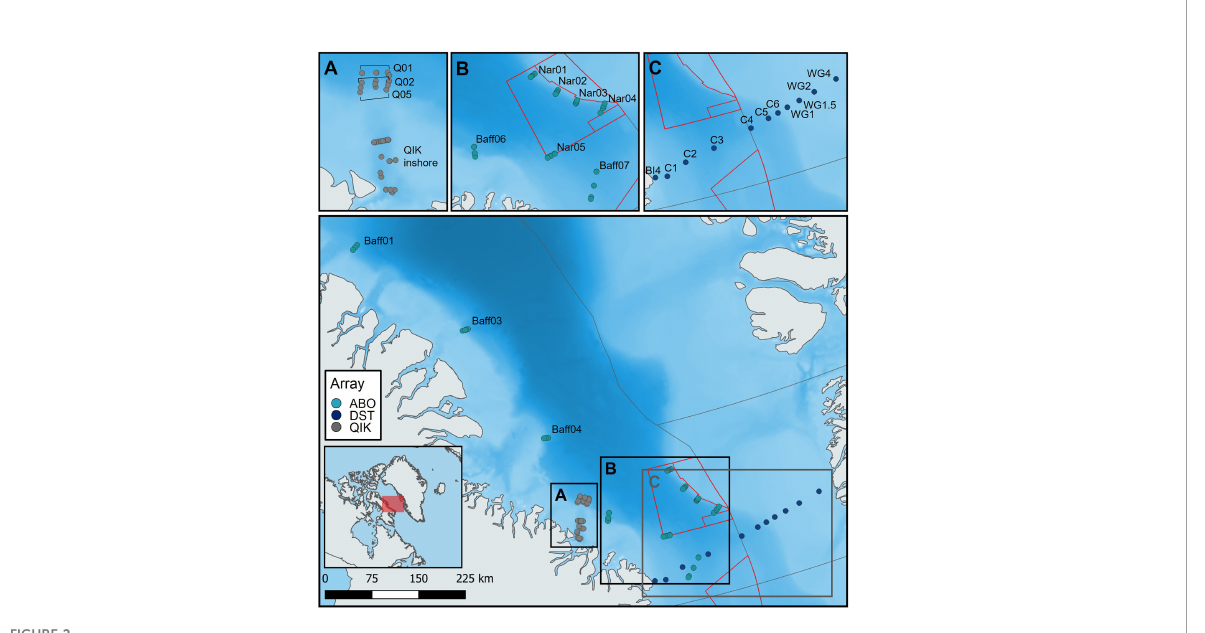
FIGURE 2 Locations of acoustic receivers used to monitor the presence of tagged Greenland sharks in offshore Baf fi n Bay. Points are coloured by array ID for each of the three offshore arrays (QIK, ABO, DST). Receiver gates in each array are labelled and depicted independently in panels (A) (QIK), (B) (ABO), and (C) (DST). [Colour